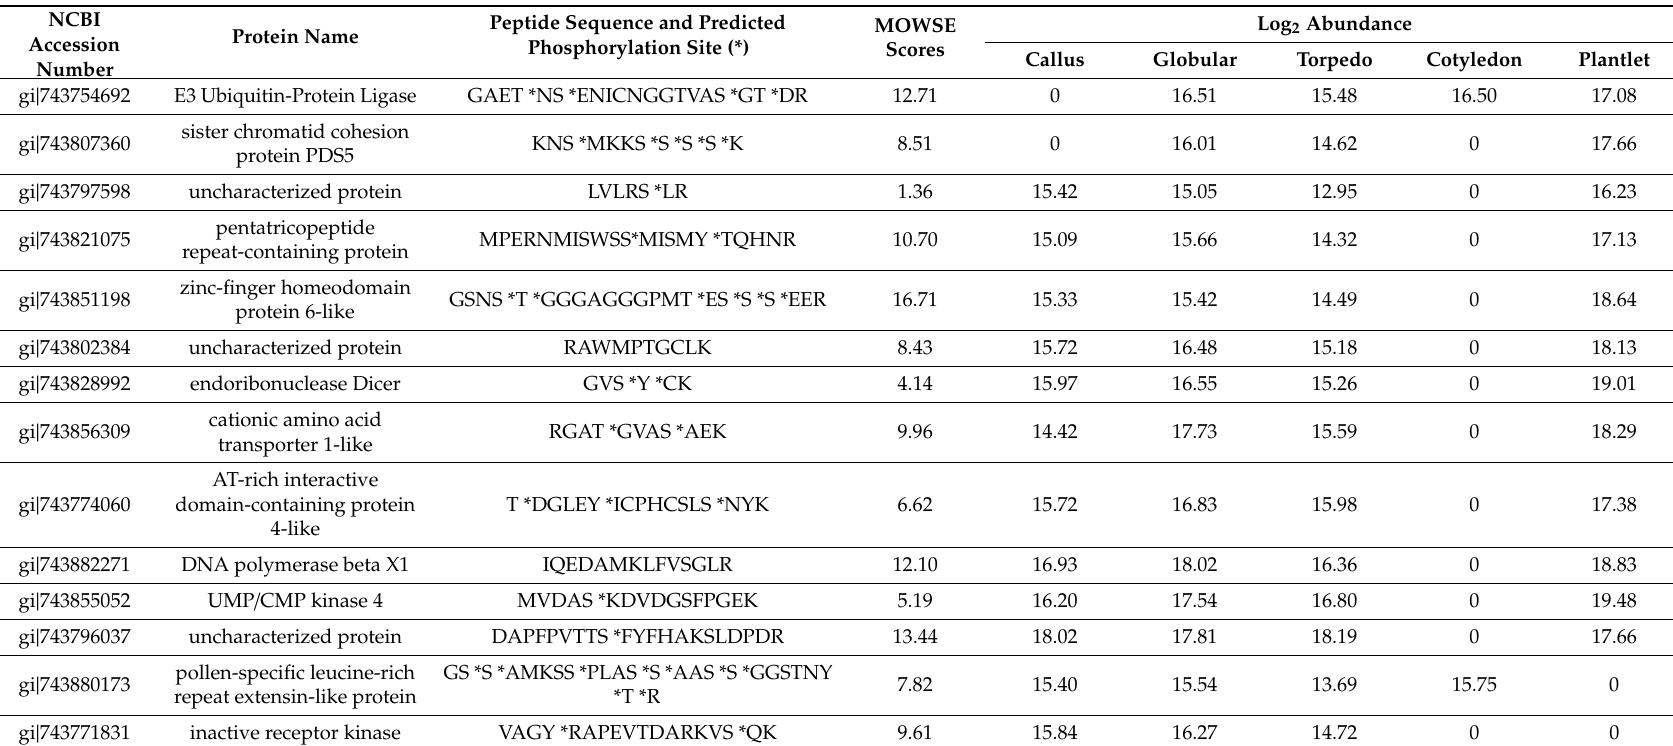
Table 1. List of di ff erentially expressed